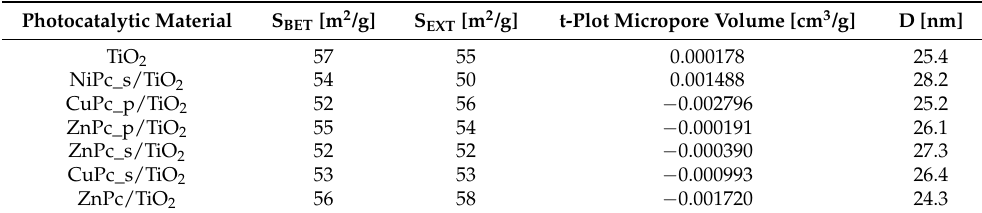
Table 3. Results of the surface area analysis using the N 2 adsorption-desorption method. S BET is the specific surface area calculated using the multilayer theory of Brunauer–Emmett–Teller and S EXT is the external specific surface calculated by the t-plot